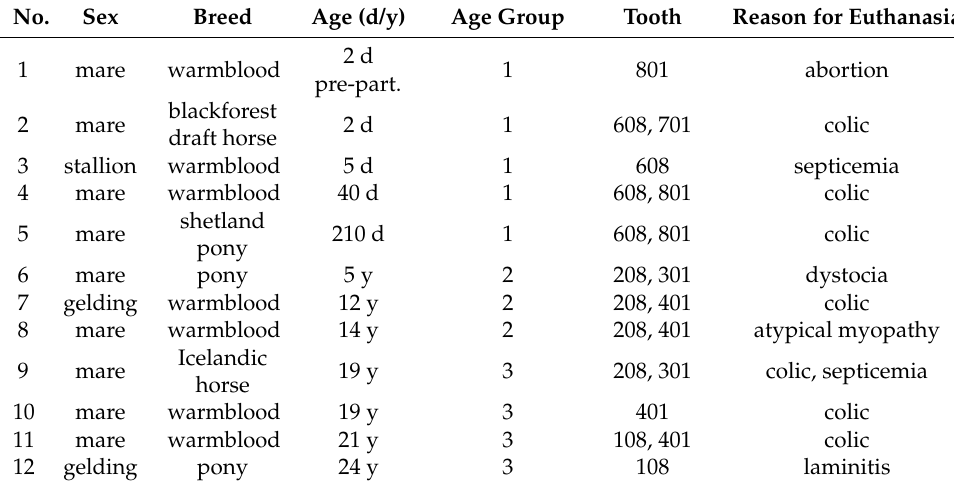
Table 1. Data of sampled